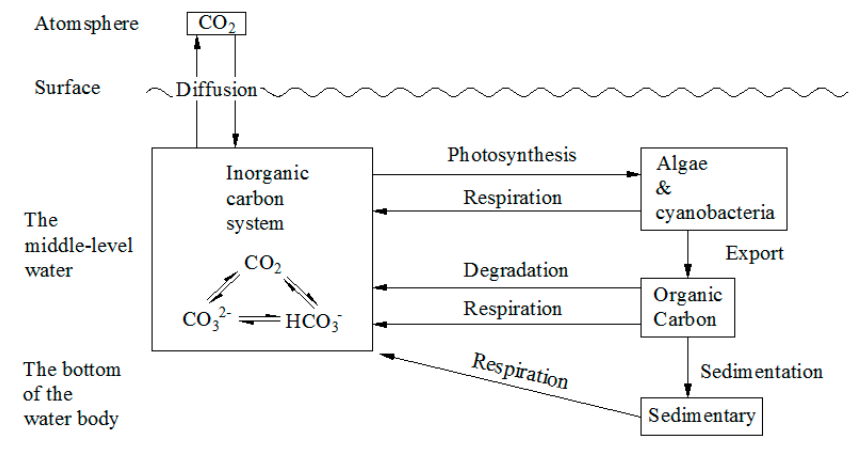
Figure 1. The carbonate cycle in the water environment [9].